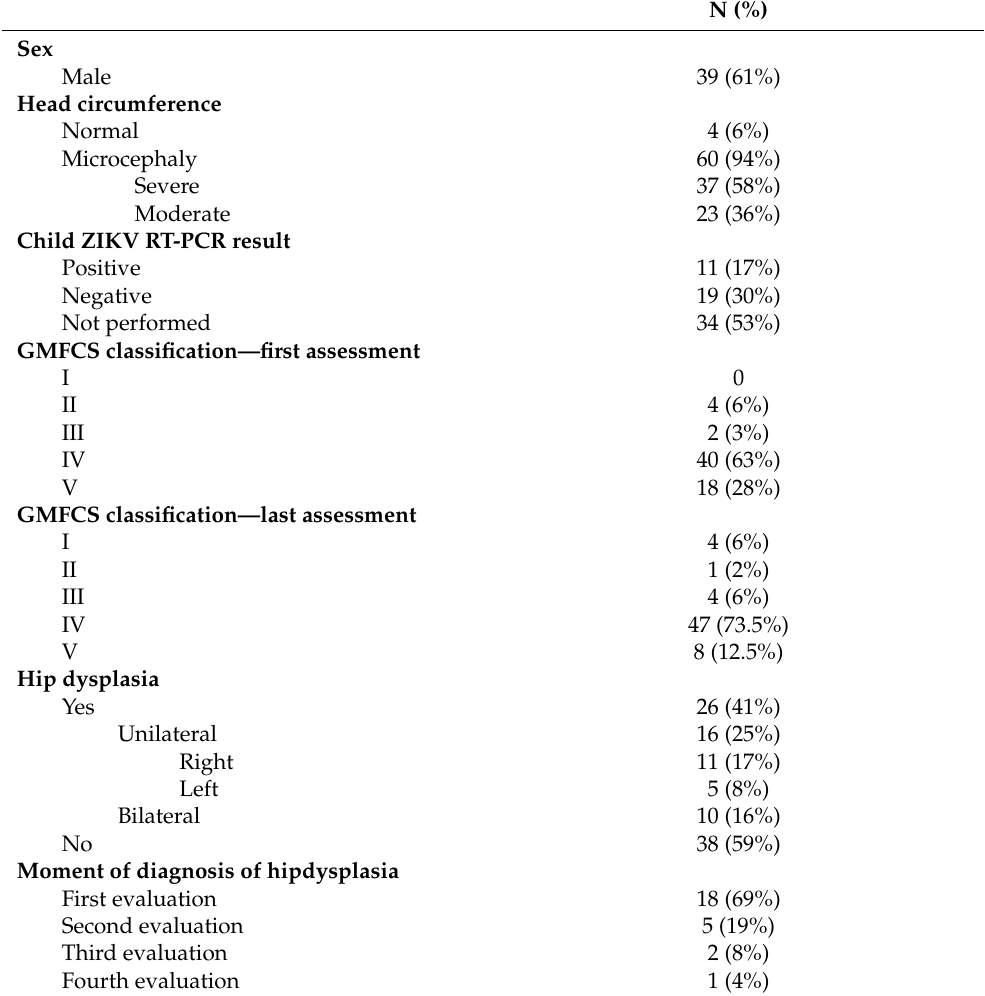
Table 1. Description of the study population (total=64).